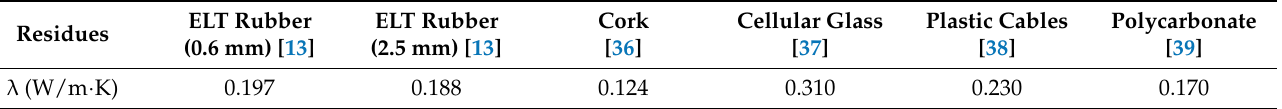
Table 6. Thermal conductivity obtained in other studies of gypsum composites lightened with synthetic residues.